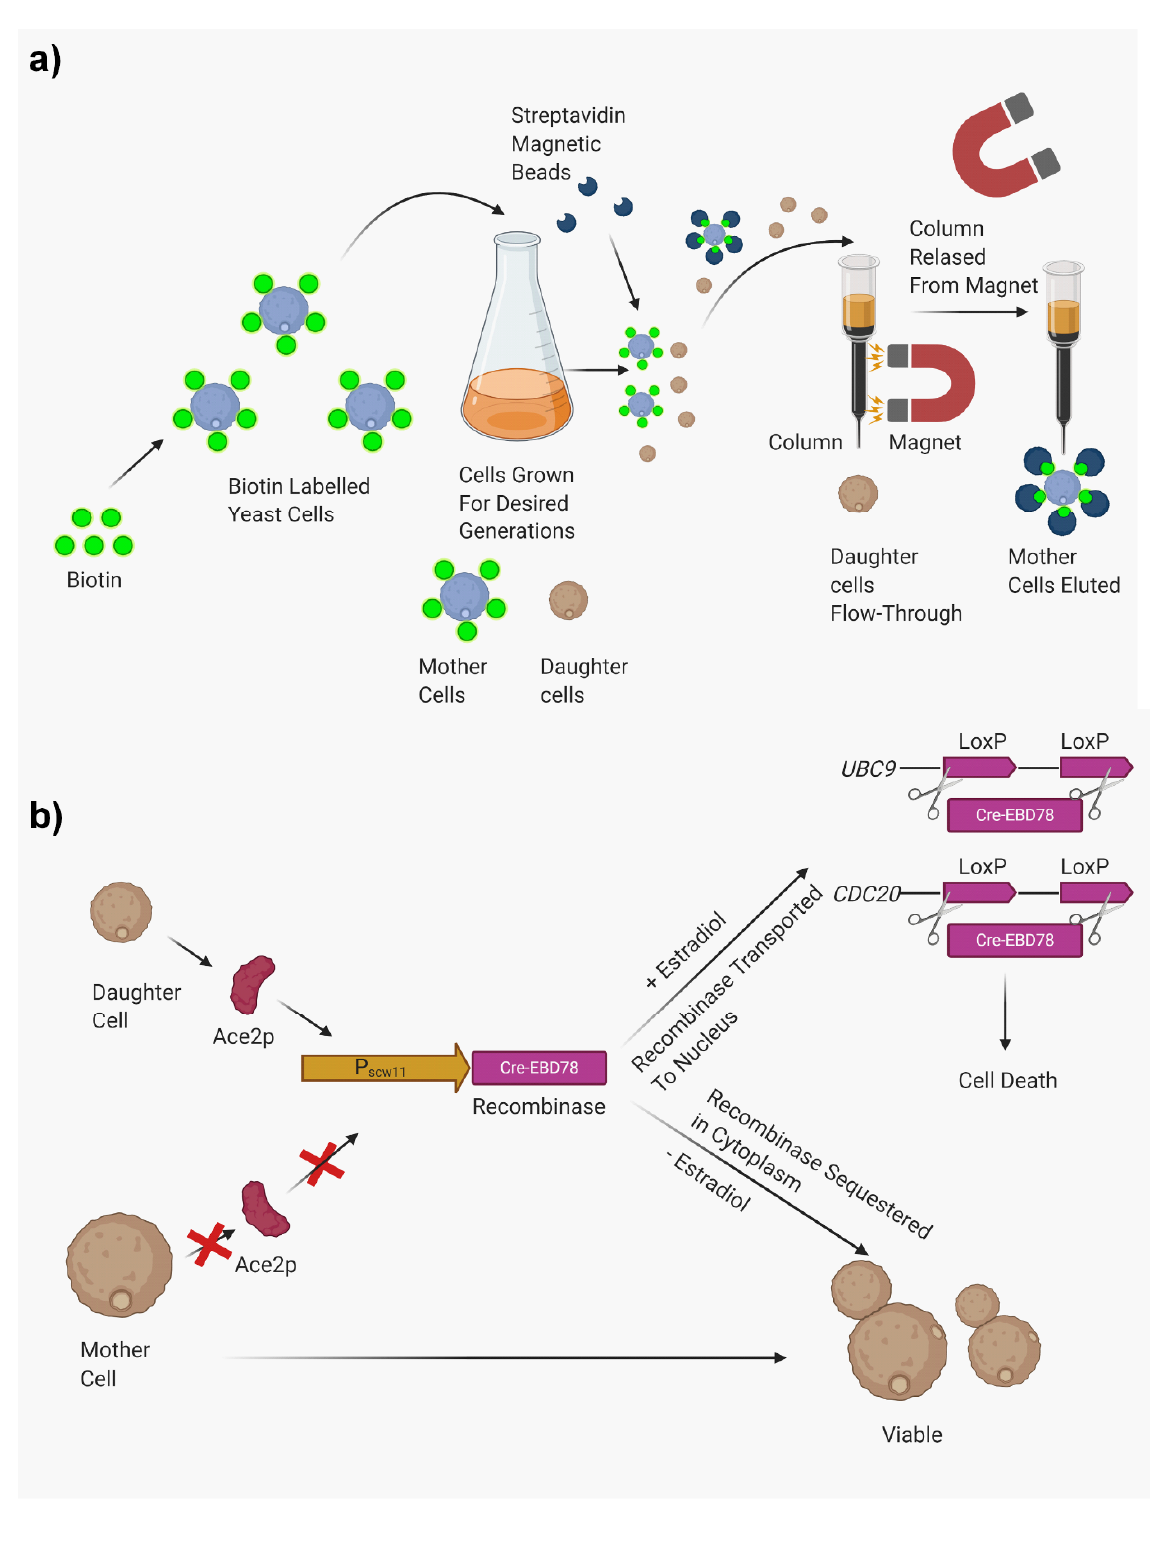
Figure 3. Methods for isolating generationally old mother cells. ( a ) Separation of generationally old mother cells by biotinylation and magnetic sorting. ( b ) Separation of generationally old mother cells by mother enrichment program (MEP). Figures were drawn with the help of biorender.com.